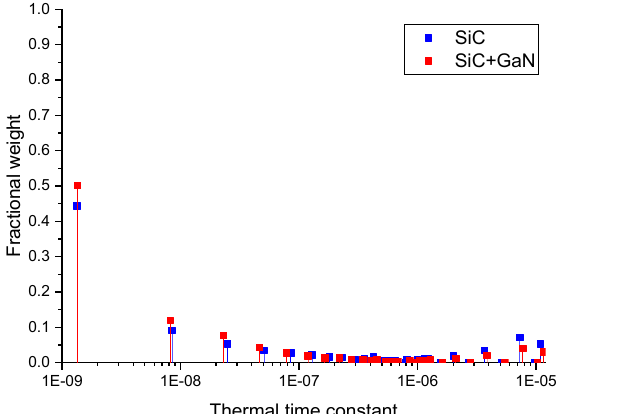
Figure 15. Normalized temperature response versus time (inset log (Temp) versus log (time)).